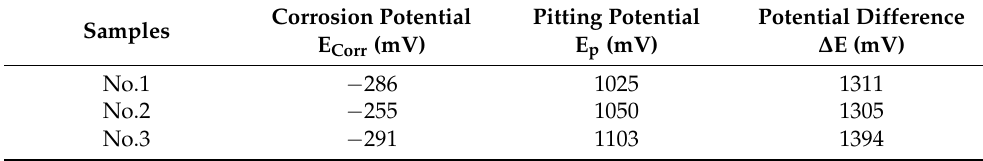
Table 4. Potential difference of welded joint under three different shielding